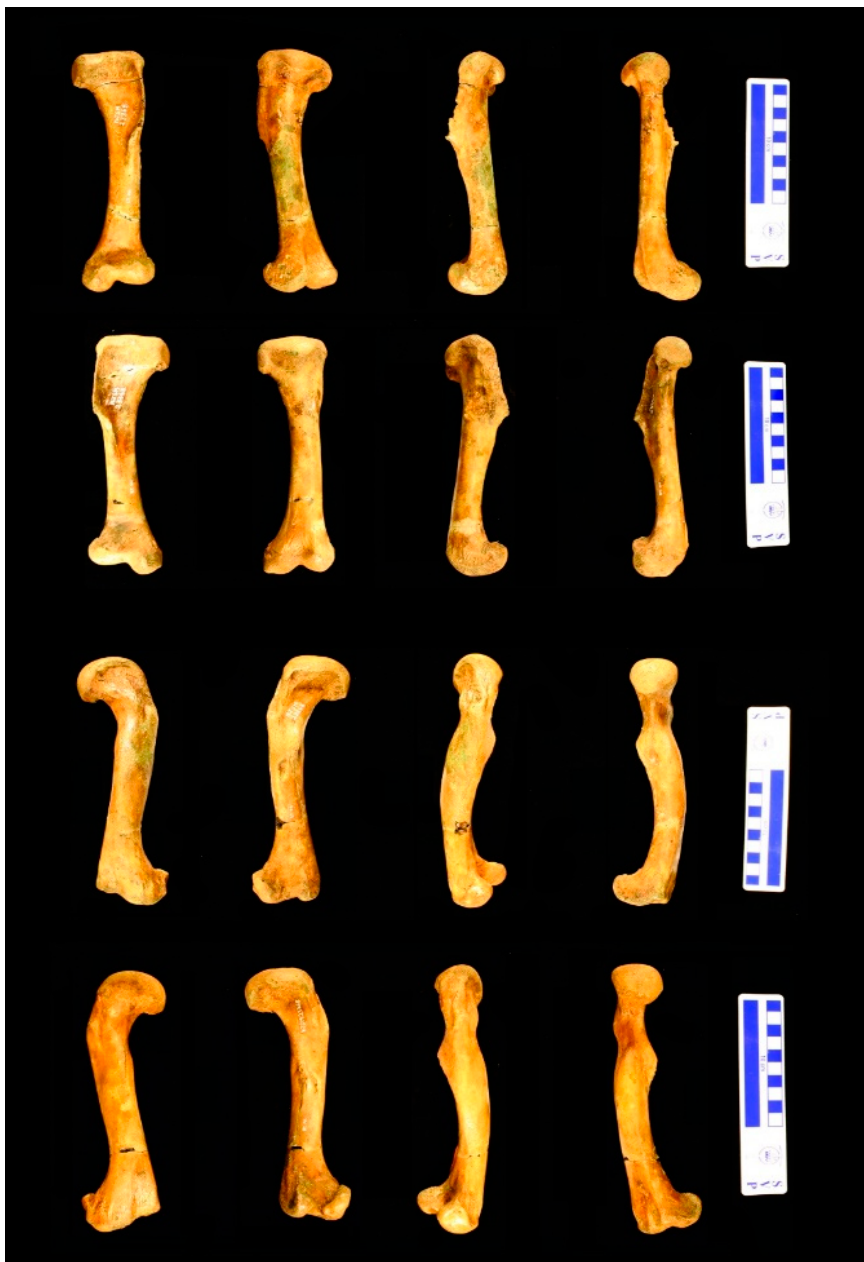
Figure 1. New Jersey State Museum (NJSM) 23368 Hyposaurus rogersii elements sectioned. The large scale bar is 10 cm. Left to right: anterior, posterior, lateral, and medial views. Top to bottom rows: left humerus, right humerus, left femur, and right femur.